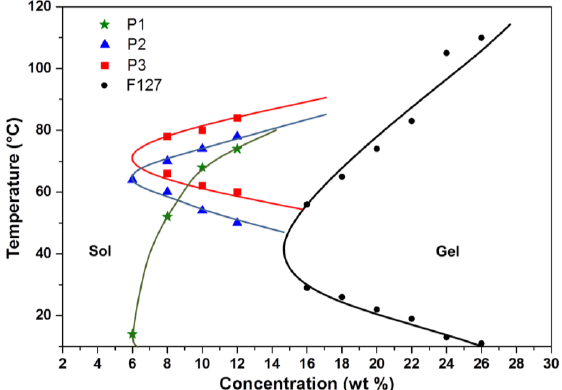
Figure 3. Sol-gel phase transition curves of poly(PEG/PPG/PTHF carbonate urethane)s in aqueous solutions. Pluronic ® F127 was used as a control [56].